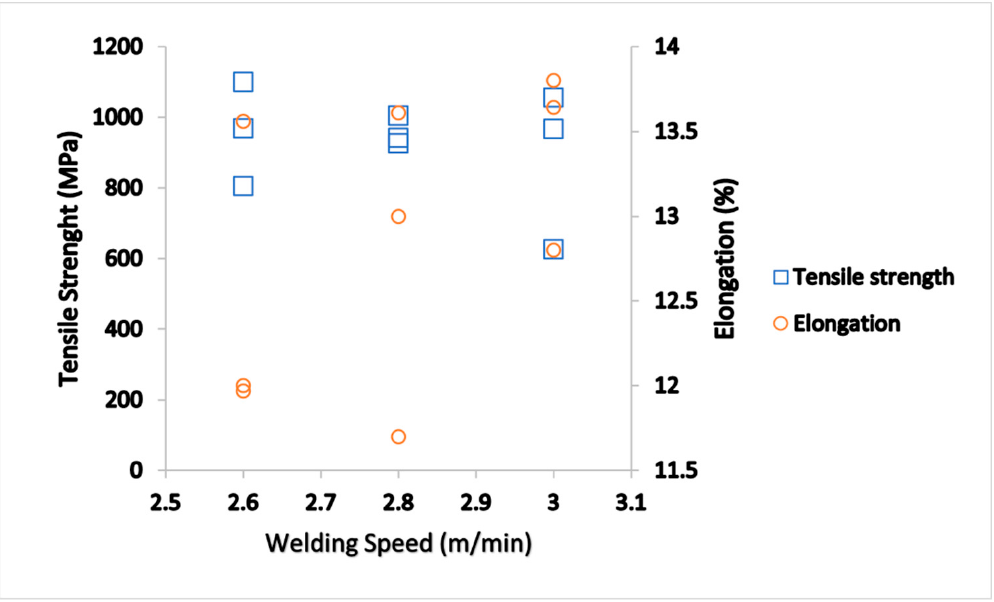
Figure 6. Tensile strength in relation with welding speed and elongation of Ti6Al4V.